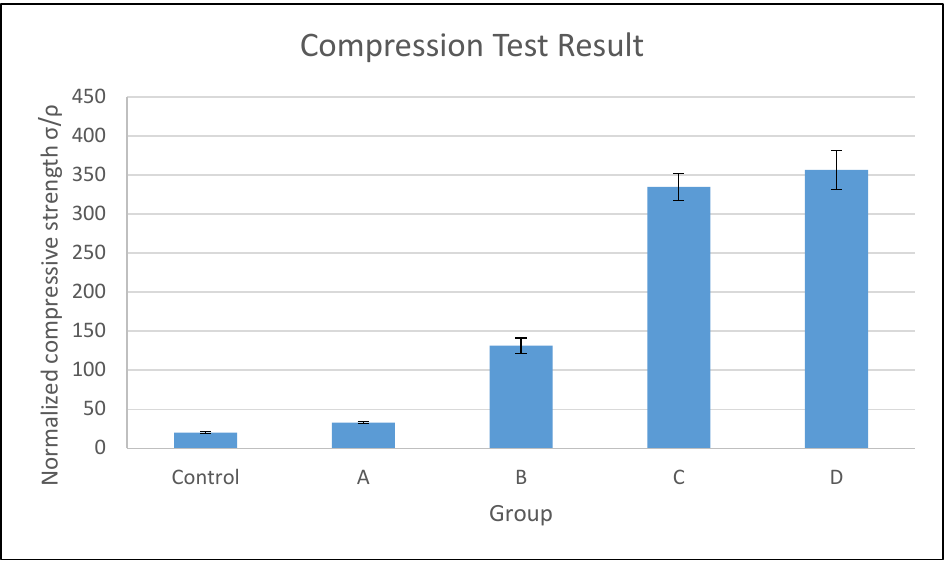
Figure 7. Compression results of PUF control and CNF-PUF with 10–40% CNF replacement ratios.